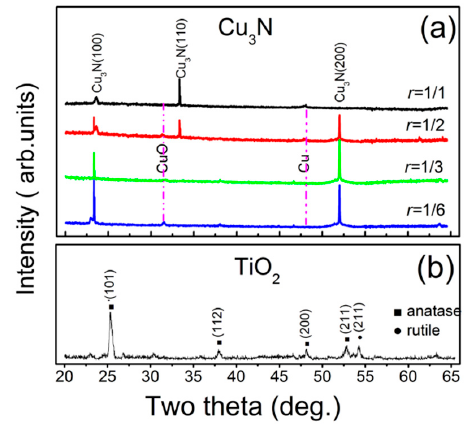
Figure 3. XRD diffraction patterns of films deposited by magnetron sputtering ( a ) Cu 3 N and ( b ) TiO 2 .